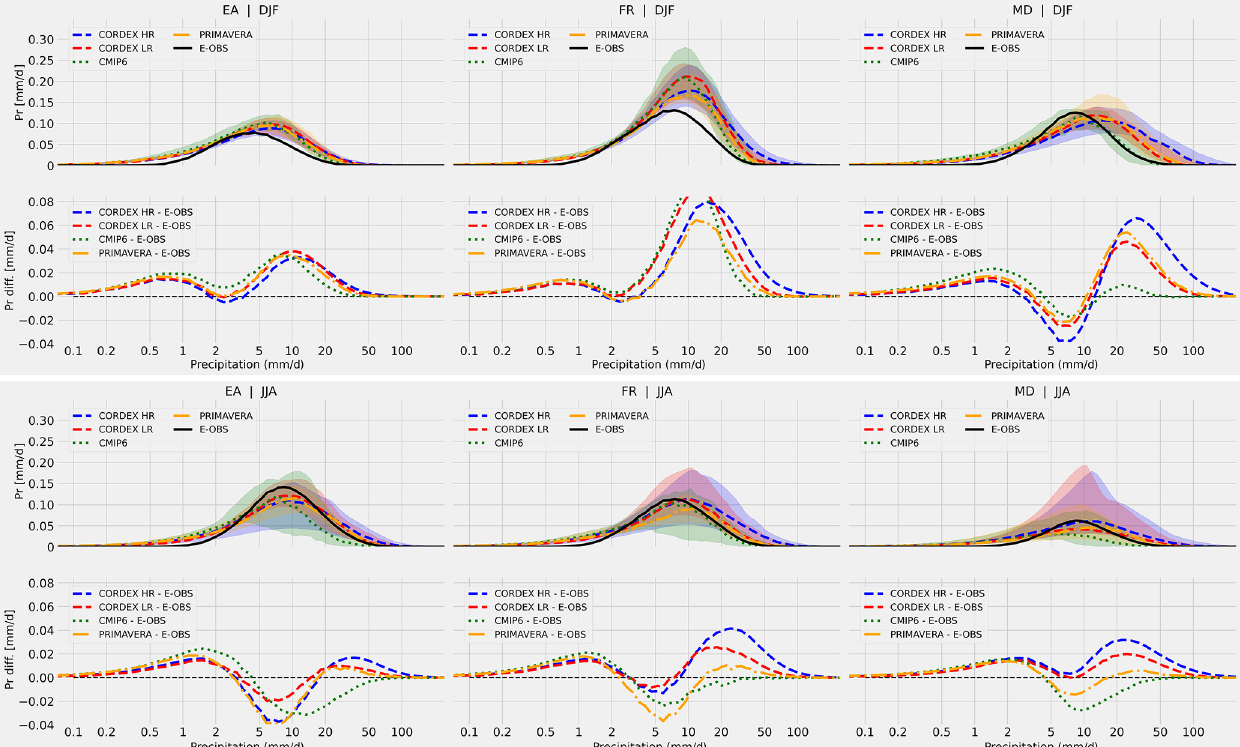
Figure 3. Same as in Fig. 2 but for DJF (top row) and JJA (bottom row) daily precipitation values and for the eastern Europe (EA, left), France (FR, middle), and Mediterranean (MD, right) regions. Coloured shadings represent the 5–95th percentile range in respective ensemble. Black solid lines are E-OBS (0.1 ◦ resolution) observations.